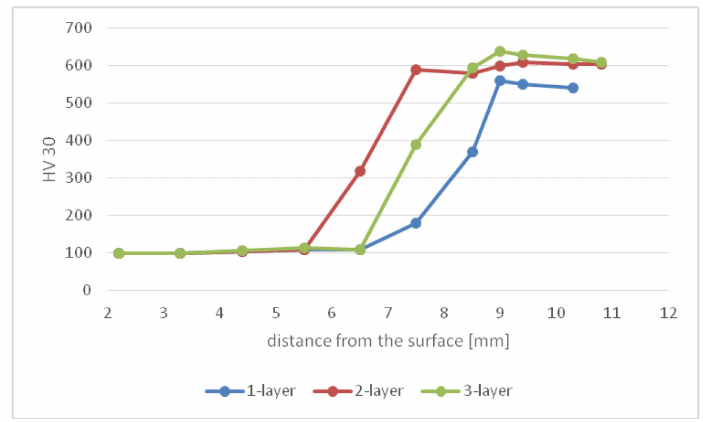
Figure 1. Course of hardness in cladding E 508 B with various numbers of layers.